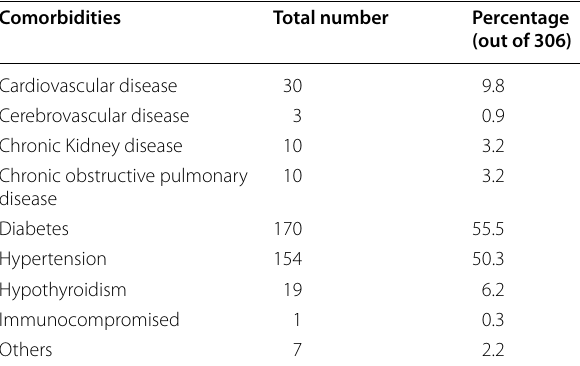
Table 1 Age distribution of the cohort